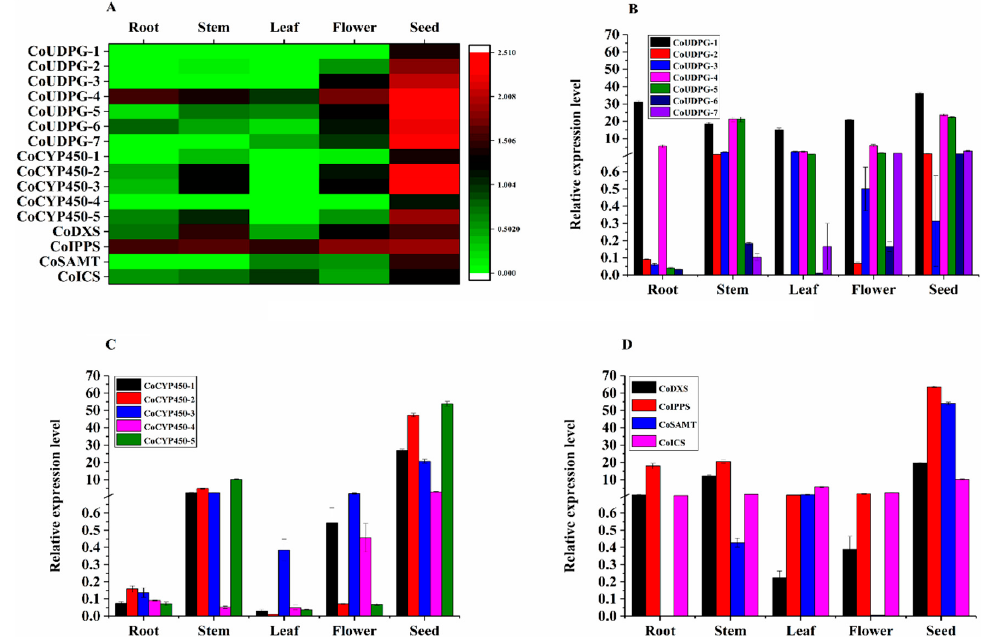
Figure 6. Heat map and following qRT ‐ PCR analysis of the various seed ‐ specific CYPs, SAM ‐ methyltransferases, UPDGs, as well as ICS, DXS, and IPPS with the highest expression level in the seed and different organs, respectively. ICS, DXS, and IPPS were known to be the potential key enzymes involved in the anthraquinone biosynthesis. ( A ) Heat map depicting differential gene expression of seed. ( B – D ) qRT ‐ PCR